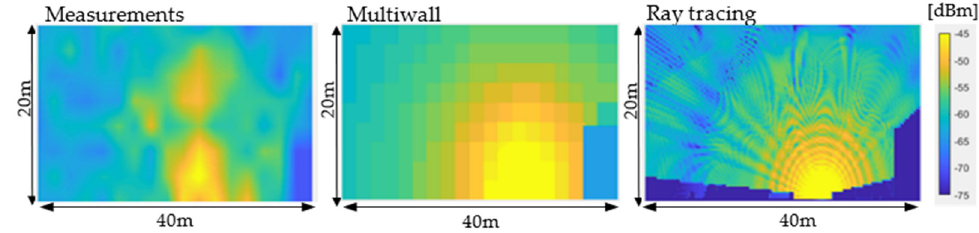
Figure 9. Distributions for one of the available sources made using measurements (first RSSI distribu- tion) and simulation methods (ray tracing and multiwall).